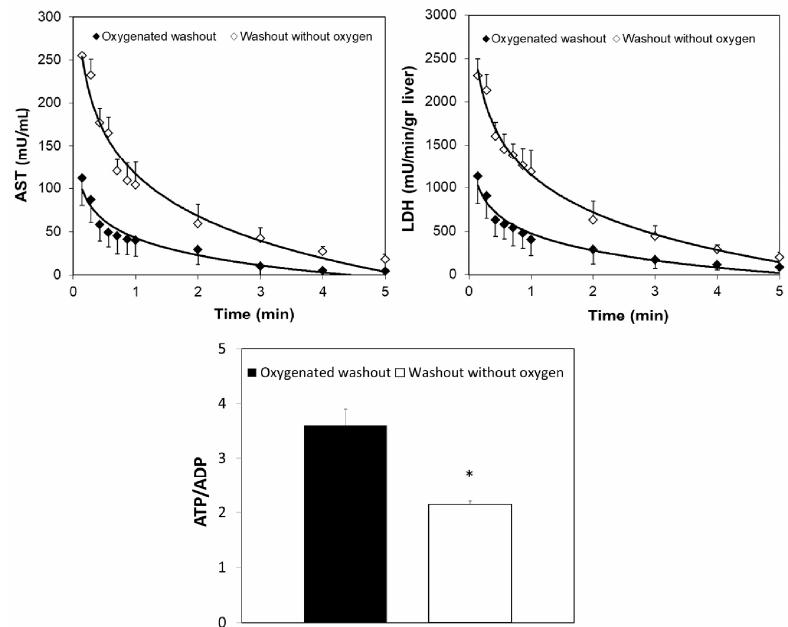
Figure 3. Effects of OW on enzyme release and the ATP/ADP tissue ratio using livers after 30 min ischemia. During the first 5 min of reperfusion, alanine-aminotransferase (AST) and lactate dehydrogenase (LDH) release were measured in the CS livers after washout in the presence or absence of oxygen. The hepatic ATP/ADP ratio was measured at the end of washout before CS preservation. The values are reported as means ± SE, n = 7/group. * <0.03.